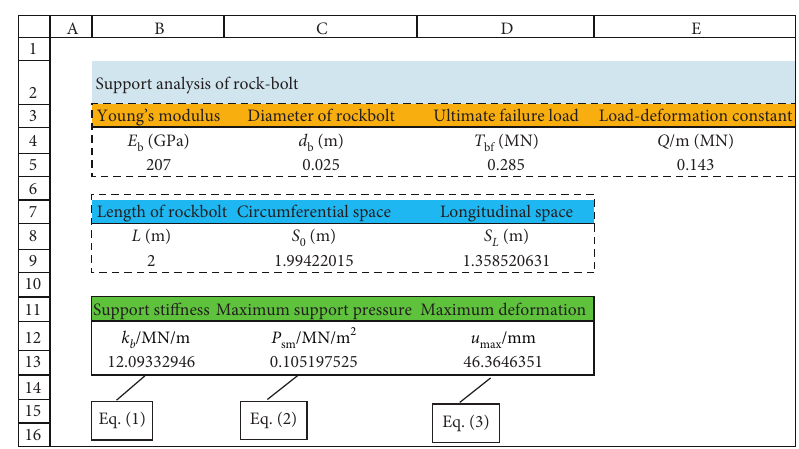
Figure 2: Support analysis of the